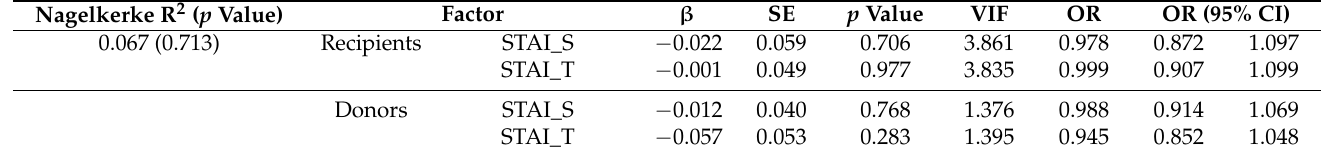
Table 5. Impact factor of STAI on choosing between PEKT and PDKT detected according to binomial logistic regulation analysis with robust standard errors. Multicollinearity was suspected if the VIF value was greater than 10. * p <